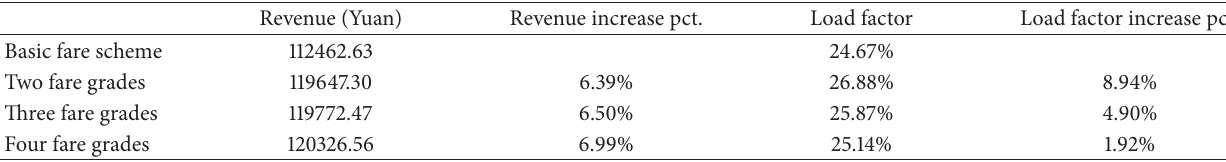
Table 3: The relation between optimal fare scheme and number of fare grades. Revenue (Yuan) Revenue increase pct. Load factor Load factor increase pct.